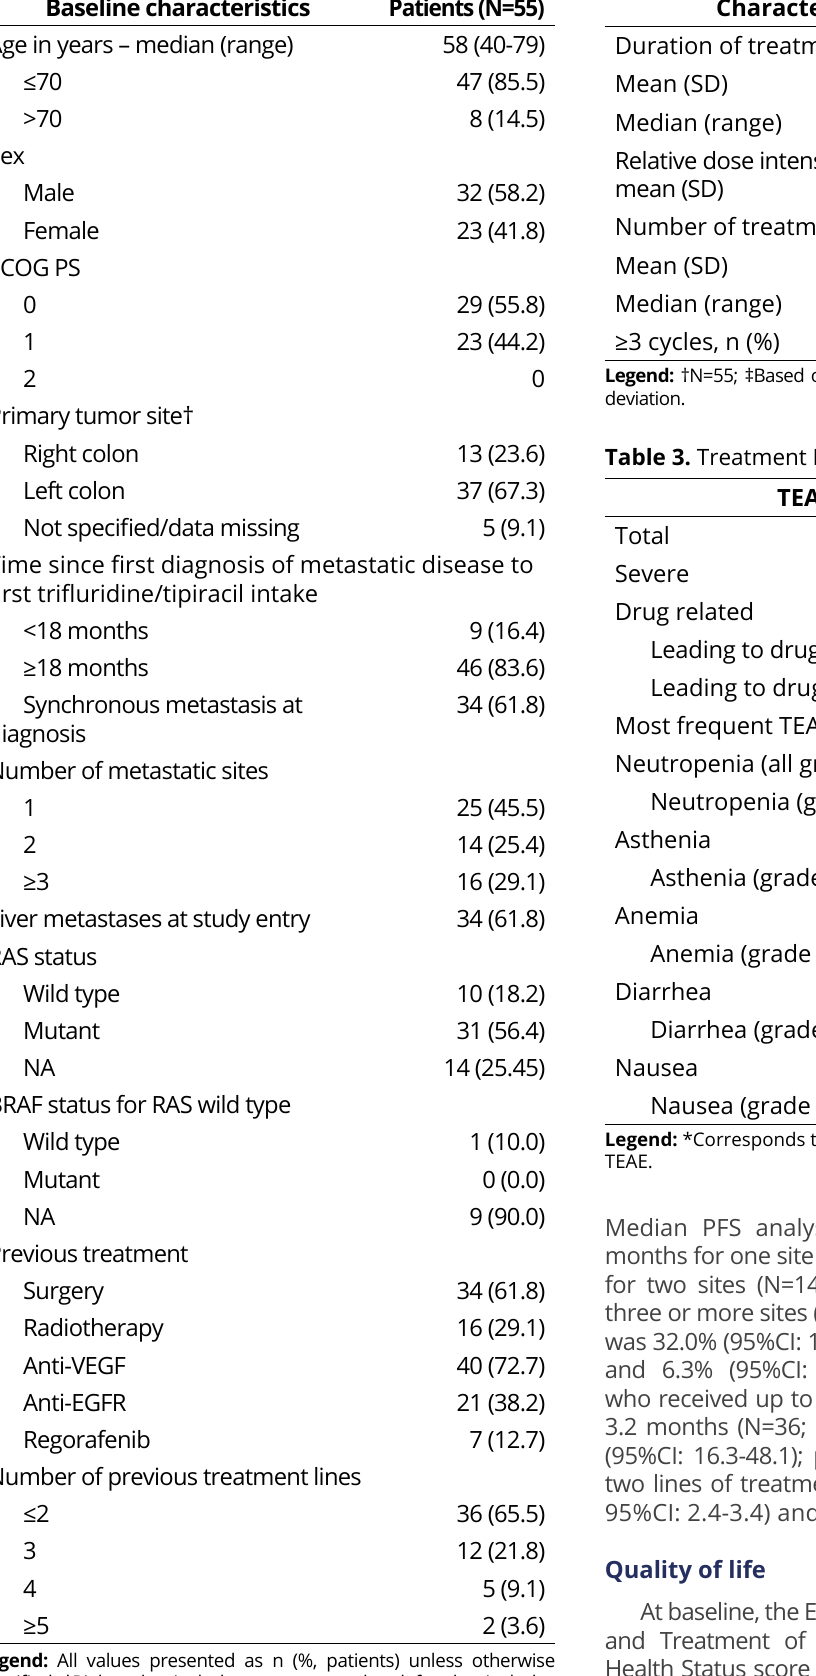
Table 1. Patients’ baseline characteristics. Baseline characteristics